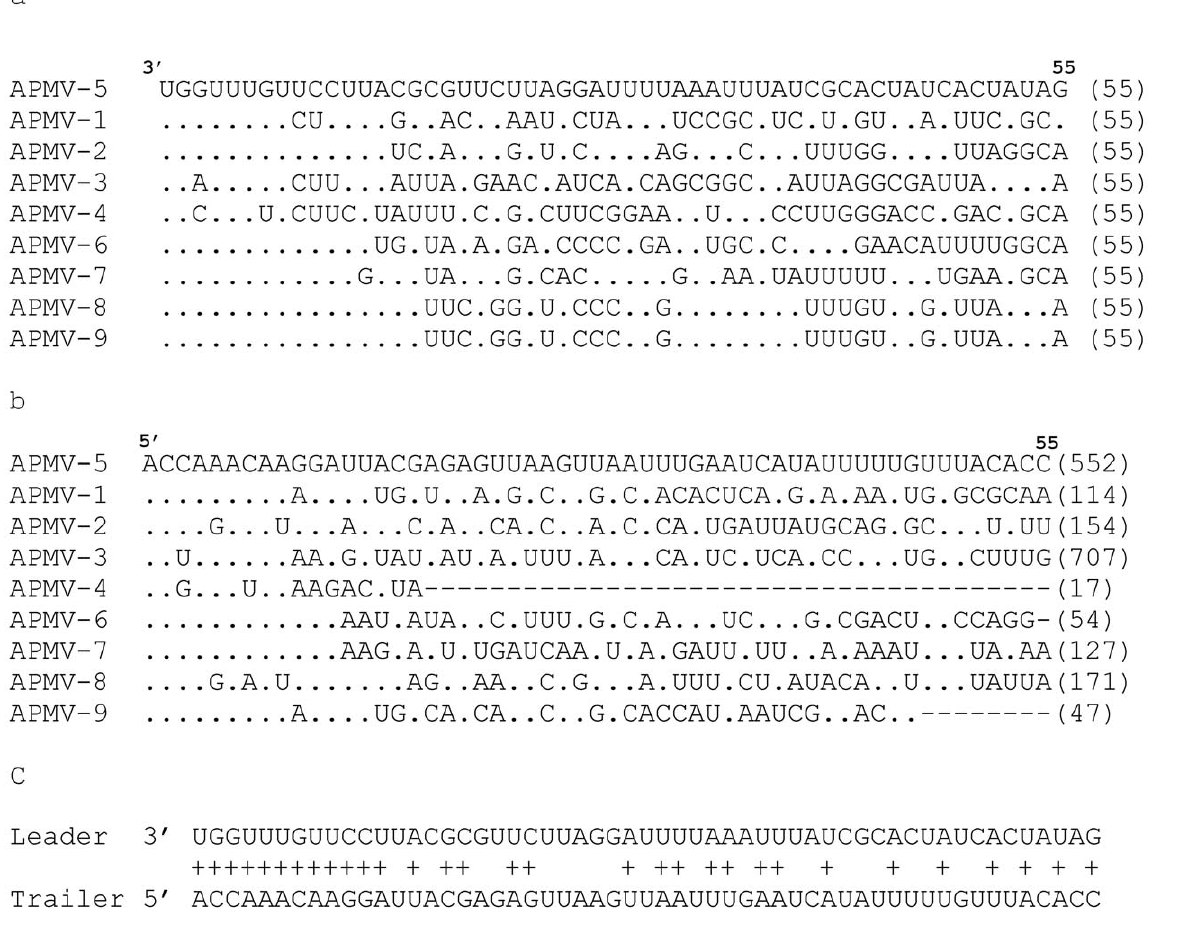
Figure 2. Alignment and comparison of Leader and trailer sequences of APMV-5 with other APMV prototype strains. Sequence alignments (negative-sense) of the (a) 3 9 -leader (b) 5 9 -trailer regions of APMV-5 with those of prototypes strains of the other eight APMV serotypes, and (c) terminal complementarity between the leader and trailer of APMV-5. Dots in (a) and (b) indicate identical nucleotides to APMV-5; crosses in (c) indicate complementarity. Gaps are indicated by dashes. The numbers in the parenthesis indicate total number of